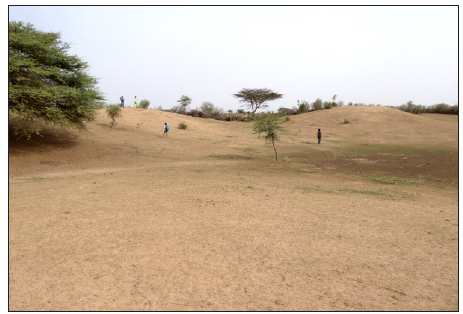
Figure 1: Fieldwork at Waalo, Senegal (Photo: K.